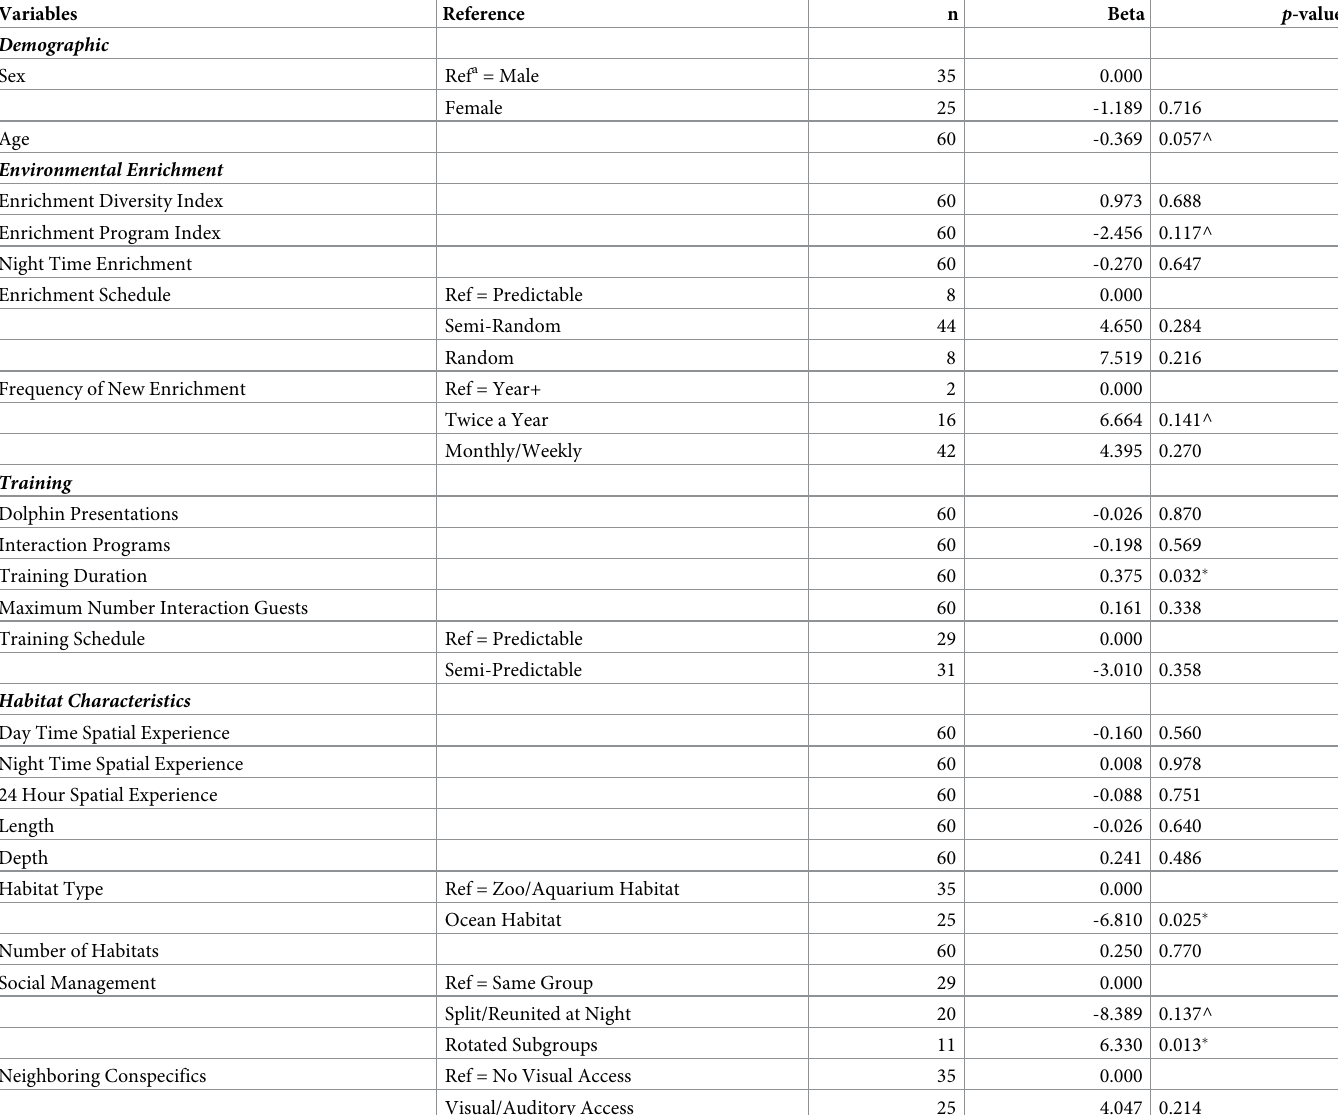
Table 3. Univariate correlations between top third habitat use and independent